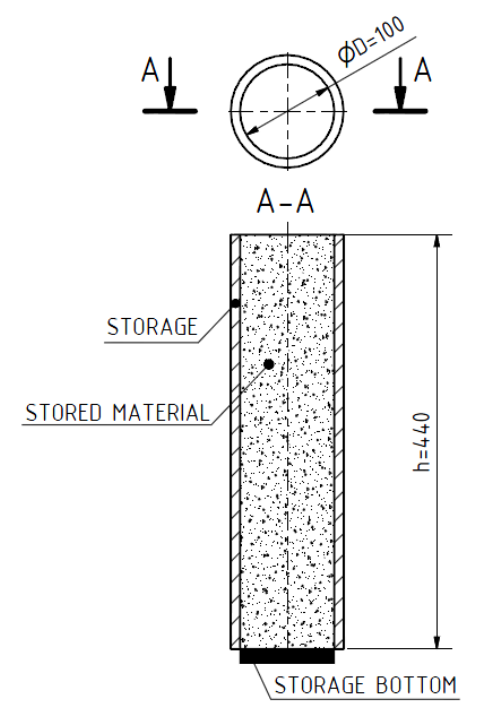
Figure 2: Diagram of the model storage